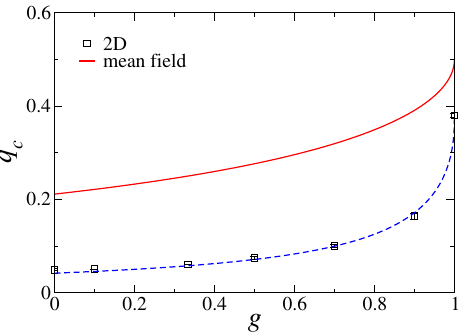
Fig. 4. Comparative phase diagram of the model in the plane q c versus g , separating the ordered and the disordered phases. The symbols are the numerical estimates of the critical points q c for the 2D case, whereas the dashed line is a sketch of the boundary, given by Eq. (10). It is also shown the mean-¯eld result 10 (full line). The error bars determined by the FSS analysis are smaller than data